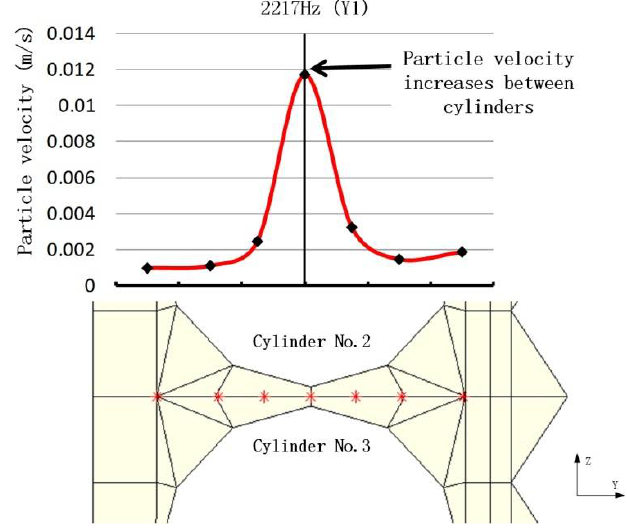
Figure 10. Distribution of particle velocity in Y-axis direction at resonance frequency 2217 Hz.